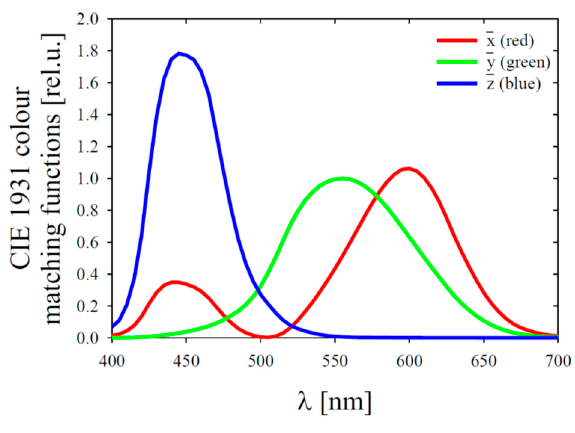
Figure 2. CIE 1931 colour matching functions.